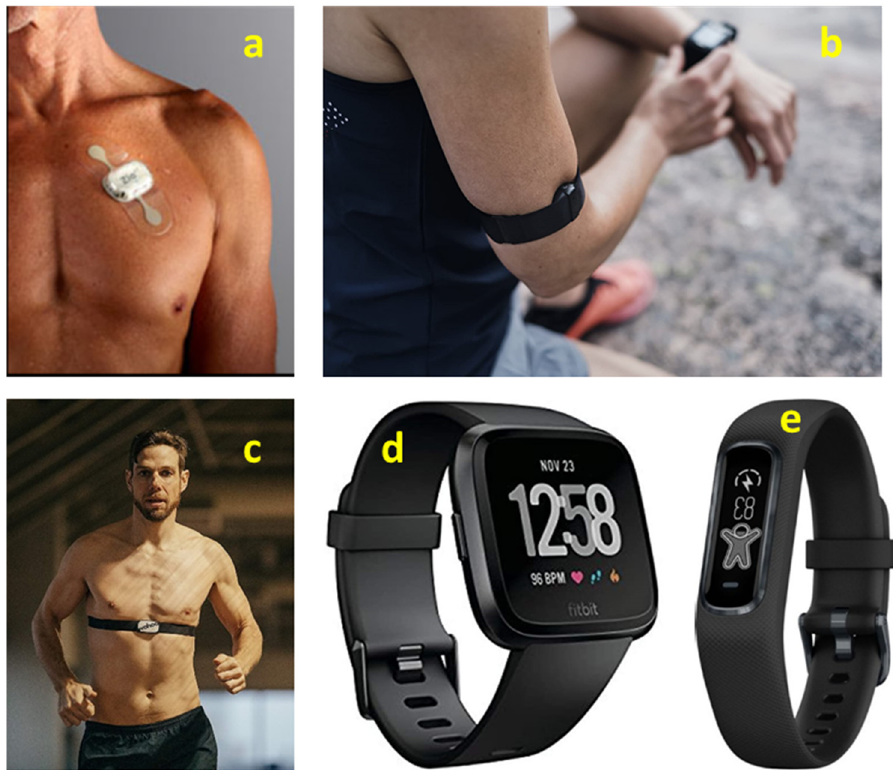
Figure 8. Examples of wearable cardiac monitors. ( a ) iRhythm ZIO AT chest patch monitor (medical grade, https://www.irhythmtech.com, accessed on 17 August 2022), ( b ) Polar OH1 upper arm band